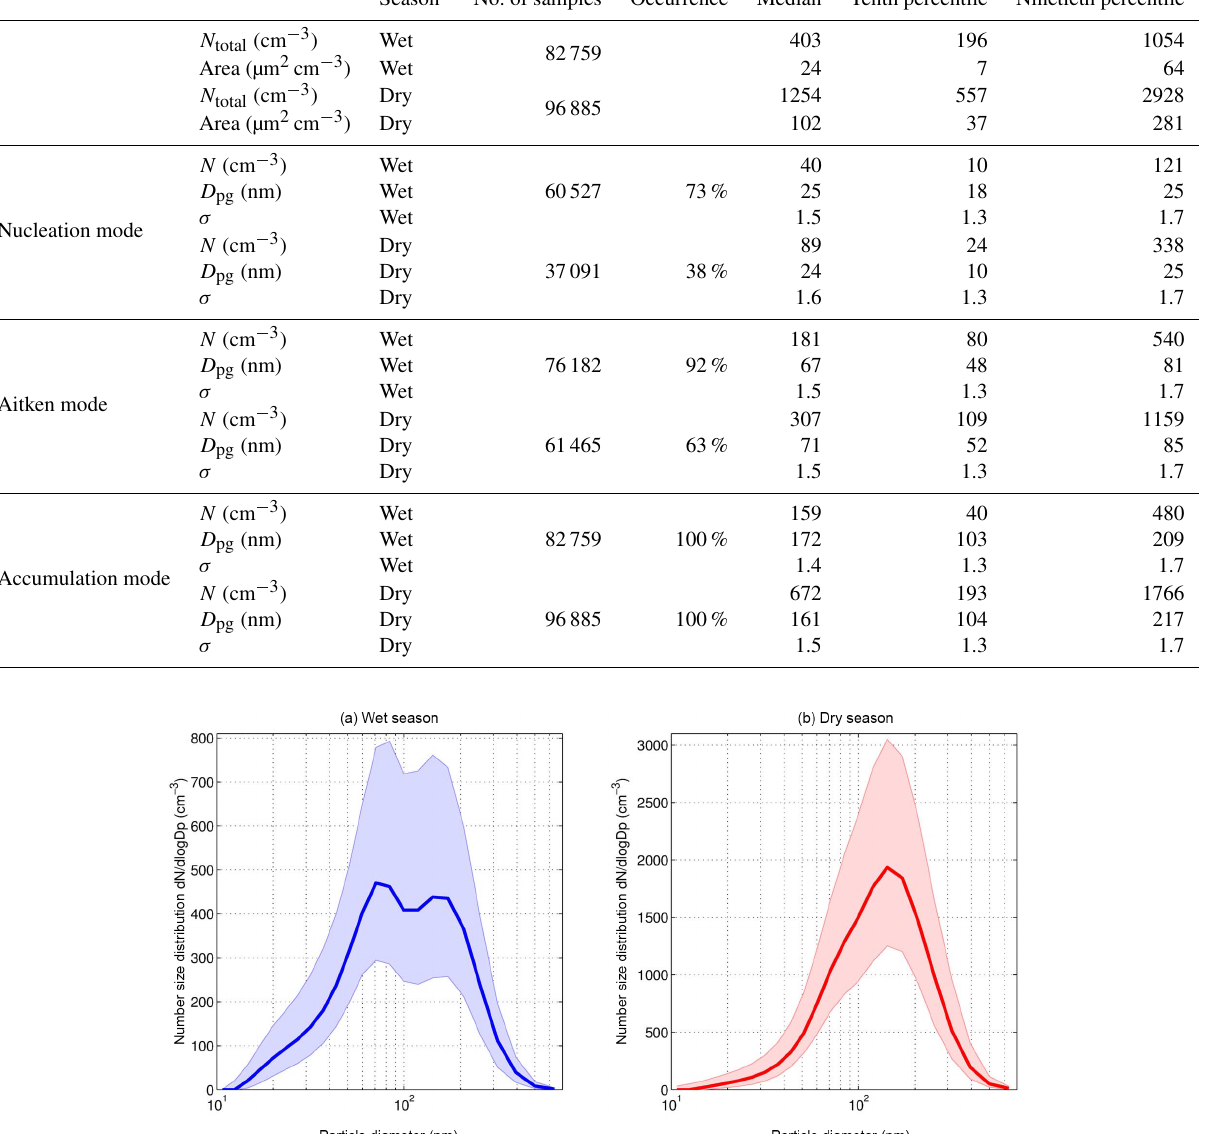
Figure 2. Median particle number size distributions for the (a) wet and (b) dry season. Shadows represent the 25th–75th percentile